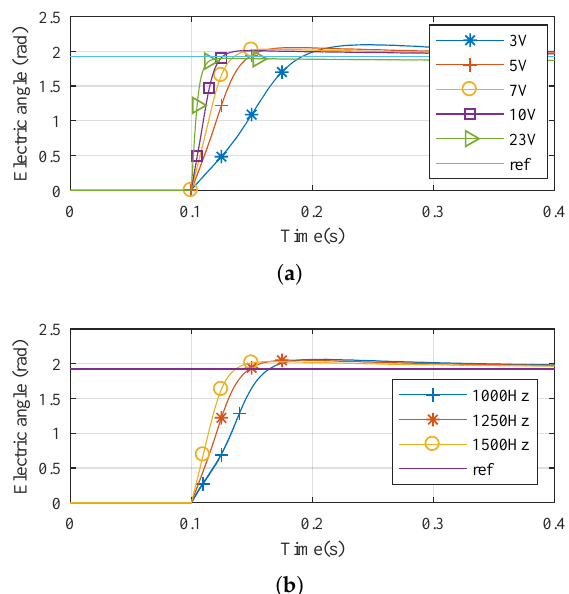
Figure 11. Injection voltage and frequency selection procedure. ( a ) Different voltage levels for a 1250 Hz frequency injection. ( b ) Different frequency levels for a 5 V amplitude injection.